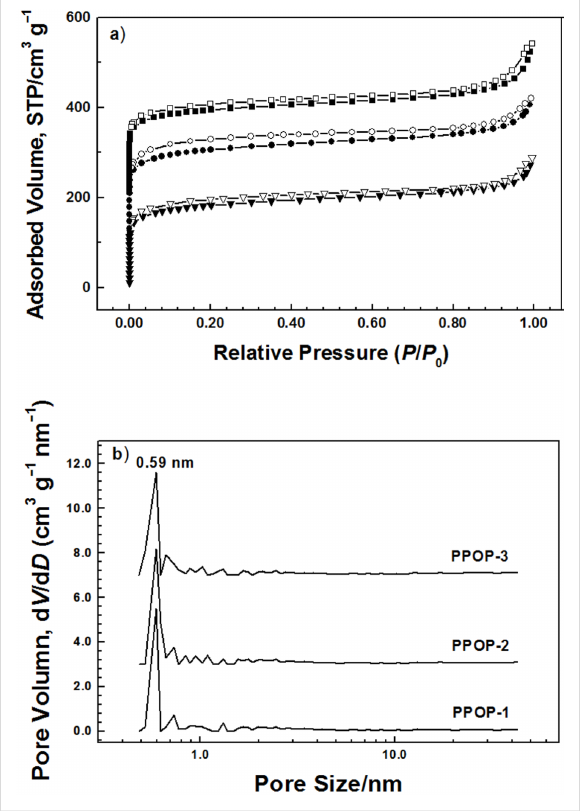
Figure 3: (a) Nitrogen adsorption–desorption isotherms of PPOP-1 (downtriangle), PPOP-2 (circle), and PPOP-3 (square) at 77 K. The isotherms have been offset by 100 cm 3 g − 1 for PPOP-2 and 200 cm 3 g − 1 for PPOP-3 for the purpose of clarity, respectively. (b) PSD profiles calculated by the original DFT method. The PSD profiles of PPOP-2 and PPOP-3 have been offset by 3 and 6 units for the purpose of clarity,